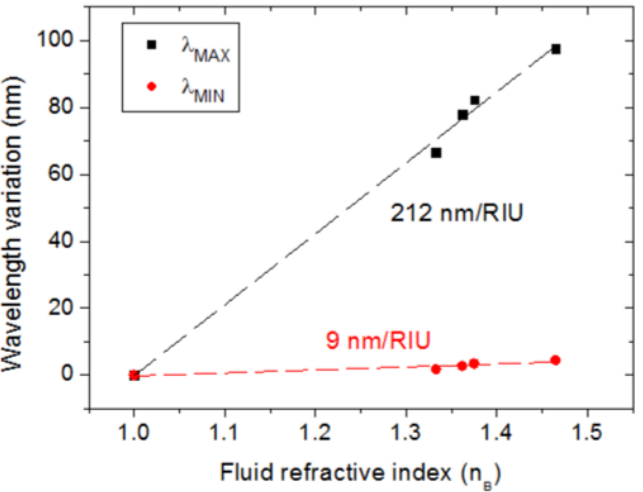
Figure 5. Variation of λ MAX and λ MIN as a function of the fluid refractive index (n B ). Dashed lines represent linear fits of the measured data points. Error bars are smaller than dots.